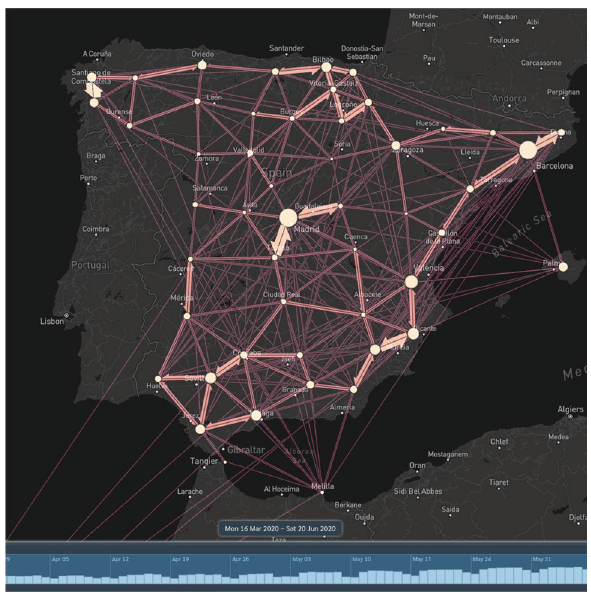
Figure 5. Mobility fluxes in Spain. Arrow size shows inter-province fluxes and dot size shows intra-province fluxes. Visualization has been created with FlowmapBlue (https:// flowm ap.